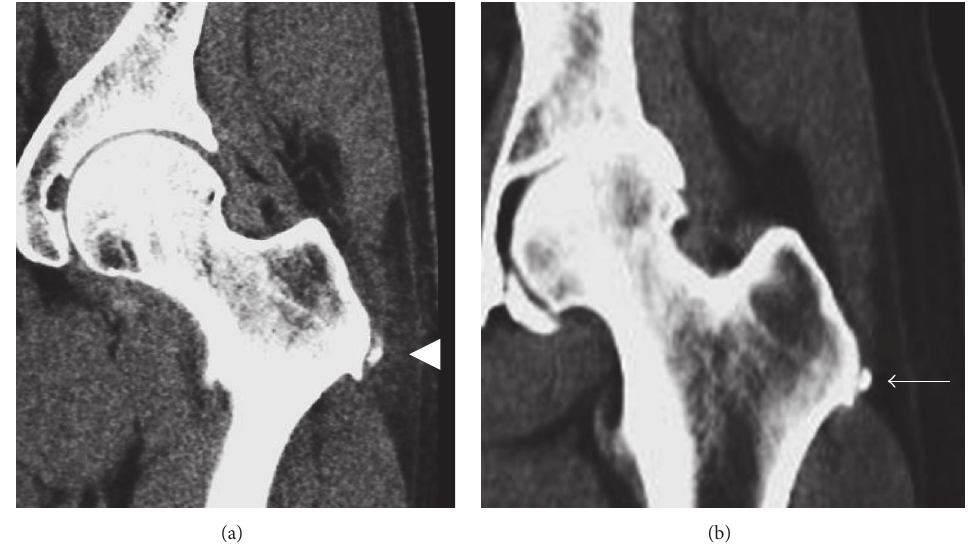
Figure 2: CT appearance of calcific tendinitis. (a) Acute symptomatic phase mirrors radiographic findings with ill-defined, amorphous calcification and associated soft tissue edema (arrowhead). (b) Calcification becomes better defined with resolution of soft tissue edema as the calcific tendinopathy progresses to the chronic phase